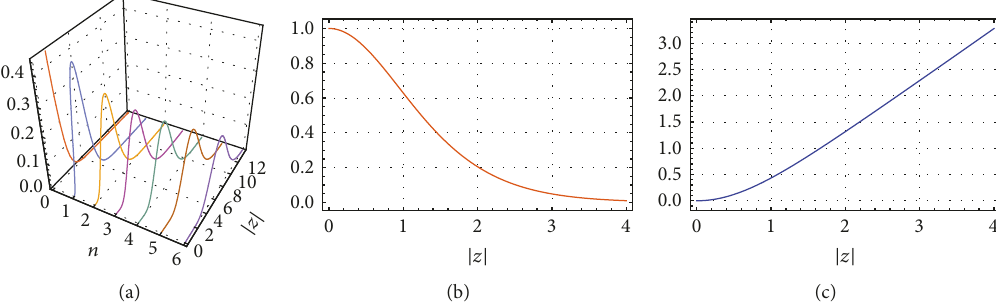
Figure 1: (a) The probability P 퐸 (𝑛,|𝑧|) of detecting 𝑛 photons associated with the SU (1, 1) coherent states (34). (b) The probability P 퐸 (0,|𝑧|) of finding the system in the vacuum state as a function of |𝑧| . (c) The average photon number ⟨̂𝑛⟩ 푧